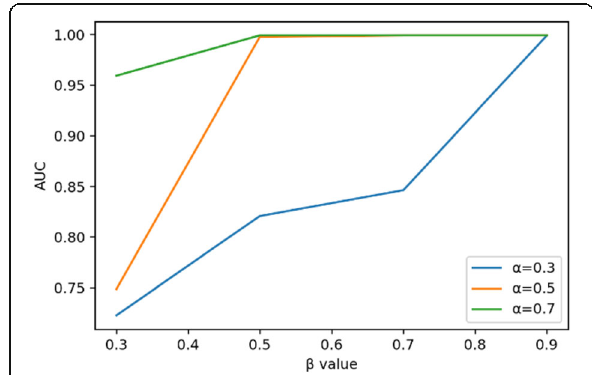
Fig. 13 The different parameters are employed in the function WJC TKA , and λ = 0.9 to obtain AUC values. α = 0.3, α = 0.5, α = 0.7